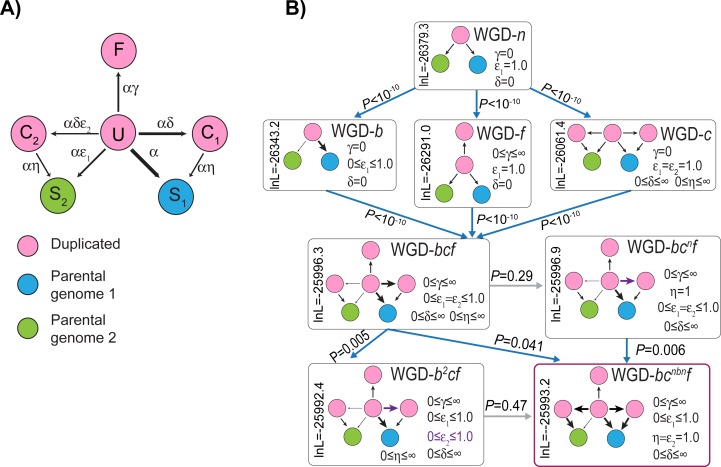
Testing nested models of post-WGD ohnolog evolution.A) Model states and parameter definitions for the set of models considered. U (Unduplicated), C1 (Converging state 1), C2 (Converging state 2) and F (Fixed) are duplicated states, while S1 (Single-copy 1) and S2 (Single-copy 2) are single-copy states (see Methods). C1 and S1 are states where the gene from the less-fractionated parental subgenome will be or are preserved, and C2 and S2 the corresponding states for the more-fractionated parental subgenome. The fractionation rate ε (the probability of the loss of a gene from the less fractionated subgenome relative to the more fractionated one) can either be the same for conversions to C1 and C2 as it is for S1 and S2 (ε1 = ε2) or it can differ (see B). The weights of the various arrows give a cartoon impression of the relative frequency of the different events: exact parameter estimates for the WGD-bcnbnf model are given in Fig 1. B) Testing nested models of WGD resolution. The most basic model (top) has neither biased fractionation nor duplicate fixation nor convergent losses. Adding any of these three processes improves the model fit (second row; blue arrows indicating statistical significance; P<10−10). Adding the remaining two processes also improves the fit in all three cases (WGD-bcf model in the third row; P<10−10). However, there is no evidence that the ε2 parameter is significantly different from 1.0 (WGD-b2cf does not improve the fit over WGD-bcnbnf, gray arrow indicating a lack of significant improvement in fit from the more complex model), implying no biased fractionation in the transitions to states C1 and C2. Likewise, there is no evidence that the η parameter is significantly different from 1.0 (WGD-bcf does not improve fit over WGD-bcnf), meaning that losses from C1 and C2 occur at similar rates as do losses from U. Hence, the WGD-bcnbnf model is best supported by these data and is used for the remaining analyses. Model names: WGD-n: Null model; WGD-b: Biased fractionation model; WGD-f: Fixation model; WGD-c: Convergence model; WGD-bcf: Bias/Convergence/Fixation model; WGD-bcnf: Bias/ Convergence (non-biased)/Fixation model; WGD-b2cf: Bias (2 rate)/Convergence/Fixation model; WGD-bcnbnf: Bias/Convergence (non-biased convergence, neutral convergent loss)/ Fixation model.